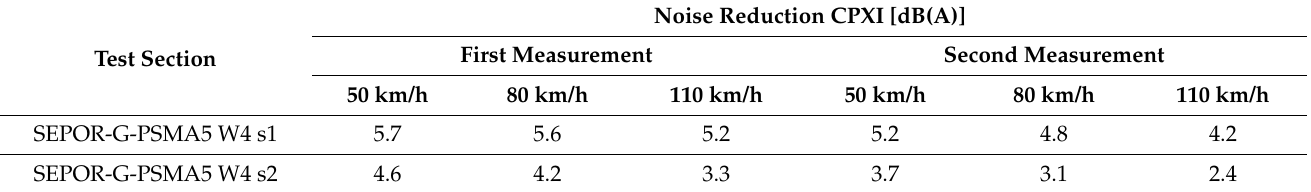
Table 9. Noise reduction of poroelastic mixture placed at the Galaktyczna long test section.